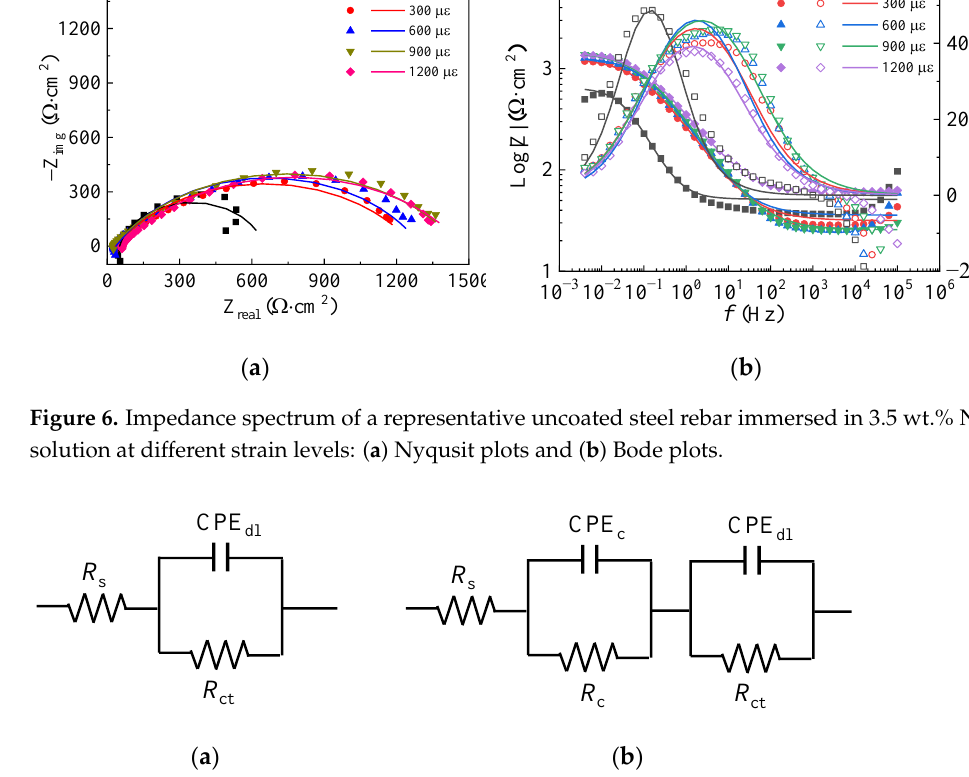
( b ) Figure 8. Impedance spectra of a representative enamel-coated steel rebar at different strain levels in the format of ( a ) Nyquist plots and ( b ) Bode plots. Figure 9 shows the effect of tensile strain on the average enamel coating resistance, which was extracted from the fitted results of the equivalent electrical circuit. It can be observed that the average enamel coating resistance decreases from 10.44 k Ω cm 2 to 1.50 k Ω cm 2 as the tensile strain increases from 0 µε to 1200 µε. The dramatic decrease in the enamel coating resistance is attributed to the generation of micro-cracks in the enamel coating under tensile strain. The micro-crack provides a pathway for the solution to pen- etrate through and reach the steel rebar, and, consequently, the coating resistance de- creases. The charge transfer resistance of both the uncoated and the enamel-coated steel rebar specimens in 3.5 wt.% NaCl solution at different tensile strain levels is compared and shown in Figure 10. Once immersed in the solution, the average charge transfer resistance of the uncoated steel rebar is 1.21 k Ω cm 2 and it increases gradually up 1.72 k Ω cm 2 as the tensile strain of the steel rebar increases to 1200 µε. For the enamel-coated steel rebar, the average charge transfer resistance increases from 55.05 k Ω cm 2 to 66.04 k Ω cm 2 as the ten- sile strain increases from 0 µε to 600 µ ε , and then gradually decreases to 57.42 k Ω cm 2 as the tensile strain reaches 1200 µε. Despite of the variation of the charge transfer resistance of the enamel-coated steel rebar specimens, the R ct of the enamel-coated steel rebar is still around 40 times greater than that of the uncoated steel rebar. Therefore, enamel coating still provides the steel rebar with strong protection against corrosion even when subjected to tensile strain, which is consistent with the results of polarization resistance, as shown in Figure 5a.